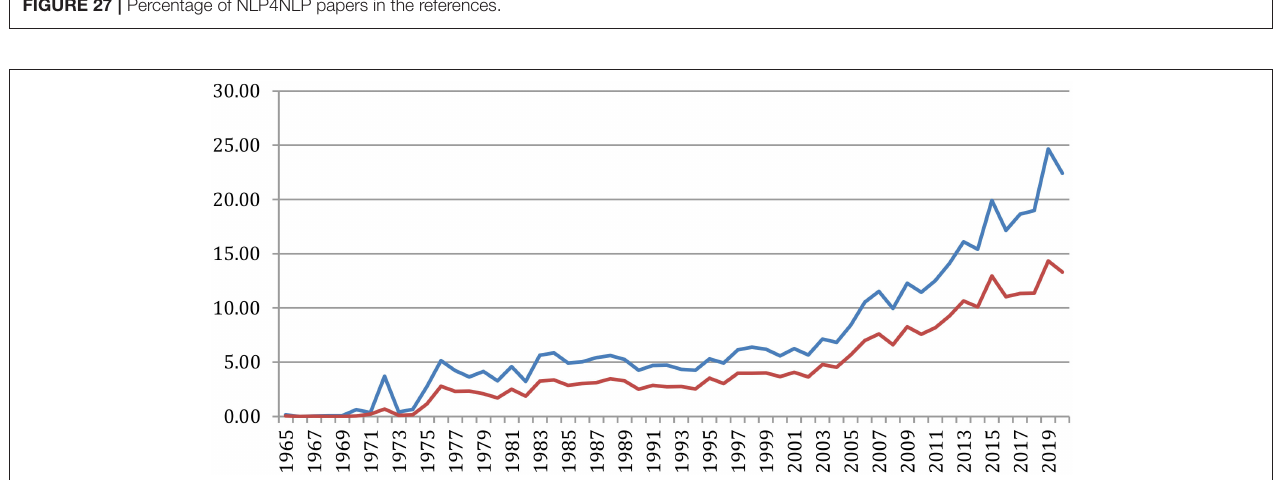
FIGURE 27 | Percentage of NLP4NLP papers in the references.